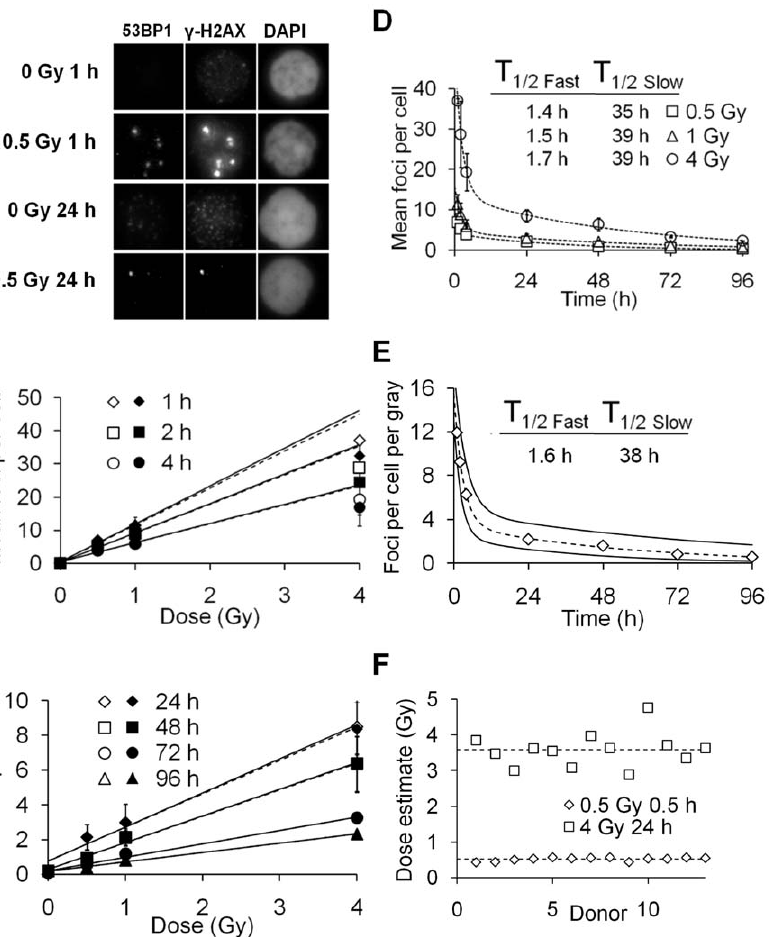
Figure 1. c -H2AX (open symbols) and 53BP1 (closed symbols) foci induction and loss after uniform exposure to X-rays, detected by immunofluorescence microscopy. (A) Grey scale immunofluorescent images of 53BP1, c -H2AX and DAPI in irradiated lymphocytes and controls. Each image is 8.4 6 7.6 m m in size. (B) Mean c -H2AX and 53BP1 foci observed between 1–4 hours post exposure. Linear regressions (solid lines for c - H2AX, dashed for 53BP1) were fitted excluding the 4 Gy data points due to underscoring of foci. (C) Mean c -H2AX and 53BP1 foci observed between 24–96 hours post exposure. Linear regressions (solid for c -H2AX, dashed for 53BP1) are fitted to all data points. (D) c -H2AX foci loss over 96 hours. Dashed lines represent bi-exponential fits for c -H2AX loss for each dose. T 1/2 Fast and T 1/2 Slow represent the individual half-lives of the two exponentials. (E) c -H2AX foci yields per cell per gray between 1–96 hours calculated using linear regression coefficients of c -H2AX foci counts from Figures 1B and 1C. The dashed line represents a bi-exponential fit for mean c -H2AX loss per unit dose and solid lines the upper and lower 95% confidence limits. (F) Dose estimates in X-irradiated lymphocytes from 13 healthy donors. c -H2AX foci were scored and the dose estimated using the calibration curve from Figure 1E. The dashed lines represent the average dose estimates based on all the donors.